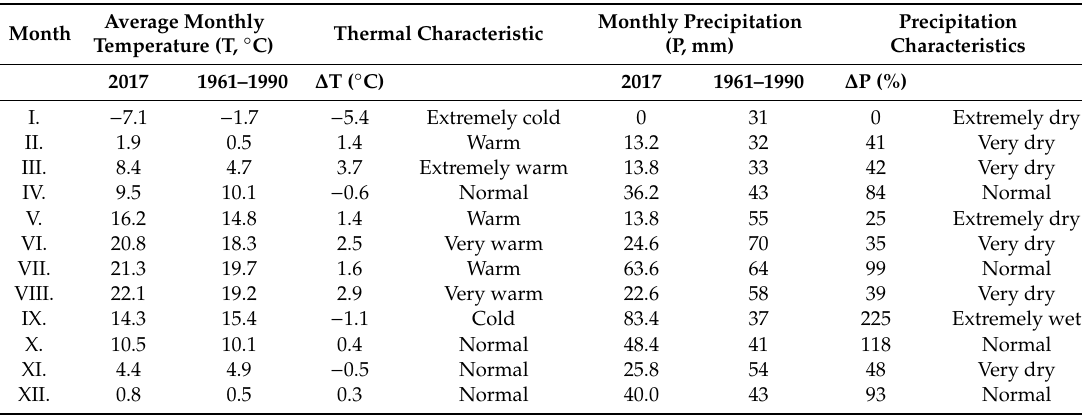
Table 3. The comparison of monthly precipitation totals and the average monthly temperature in 2017 with the climatological normal (period 1961–1990) for the locality of B á b (southwestern Slovakia). Average Monthly Monthly Precipitation Precipitation Month Thermal Characteristic Temperature (T, ◦ C) (P, mm) Characteristics ∆ T ( ◦ C)